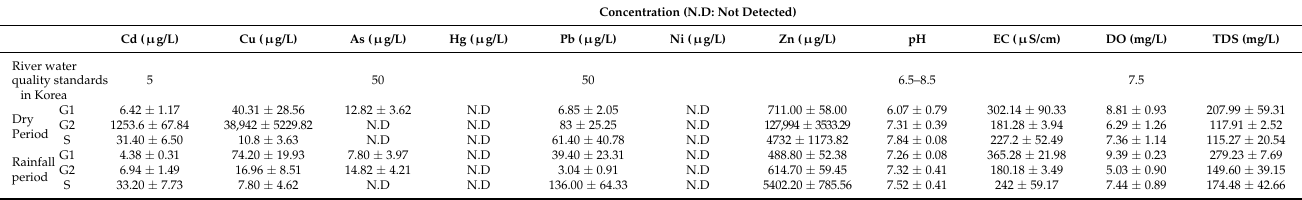
Table 2. Analysis of contaminated water samples in each monitoring